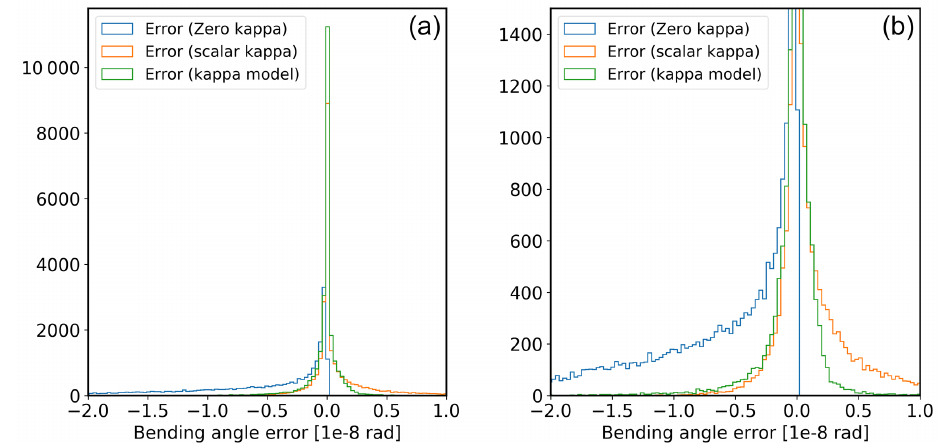
Figure 16. Histograms of globally distributed bending angle errors for zero κ , scalar κ and modelled κ . (a) Full histogram. (b) Zoomed to highlight tails.